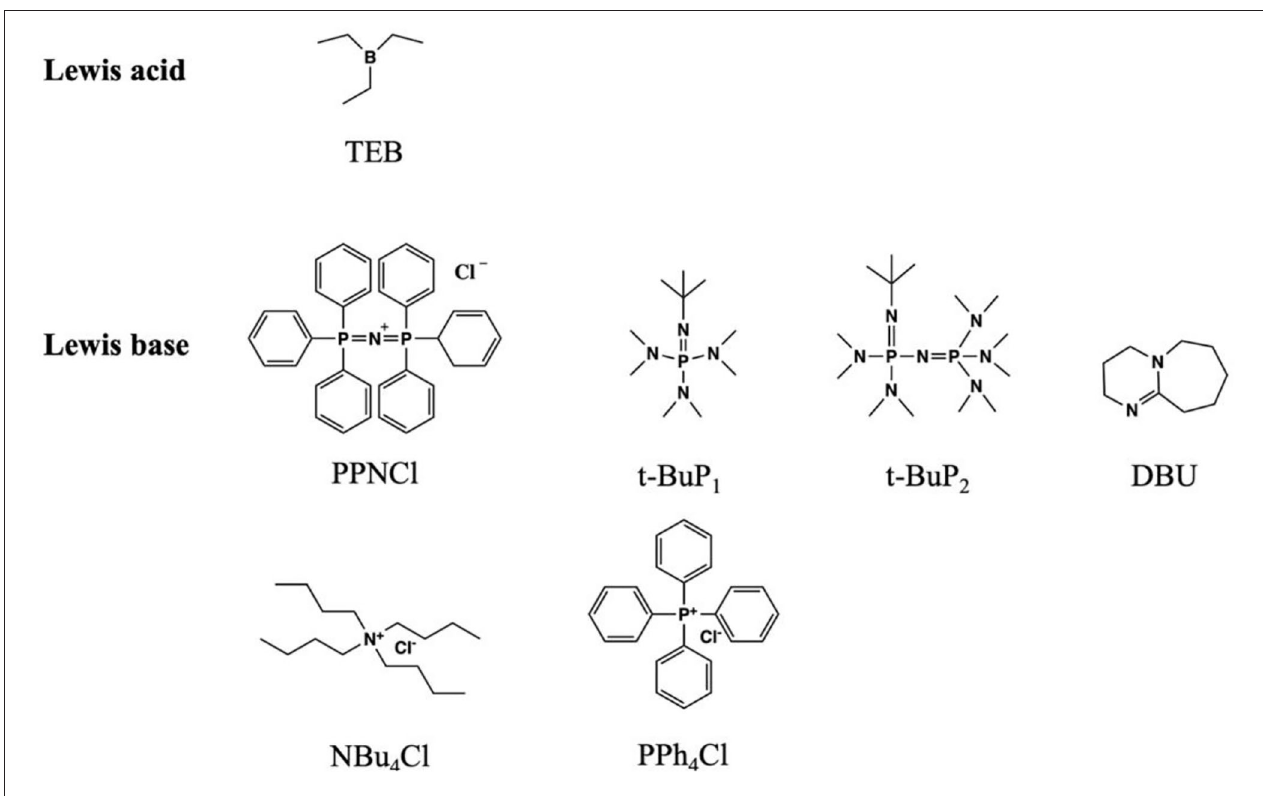
FIGURE 8 | Lewis acid and Lewis base in this article.